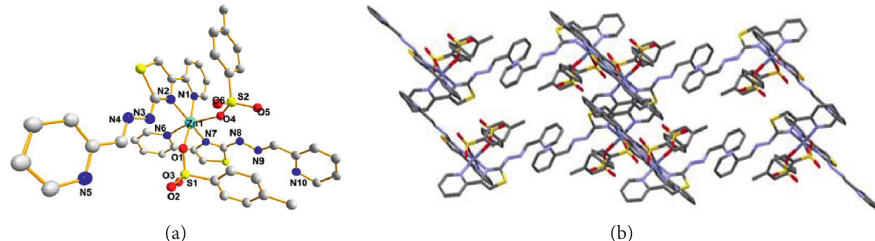
Figure 2: (a) View of the coordination environment of Zn(II) ions in 1. (b) Molecular accumulation figure viewed along b-axis in 1.